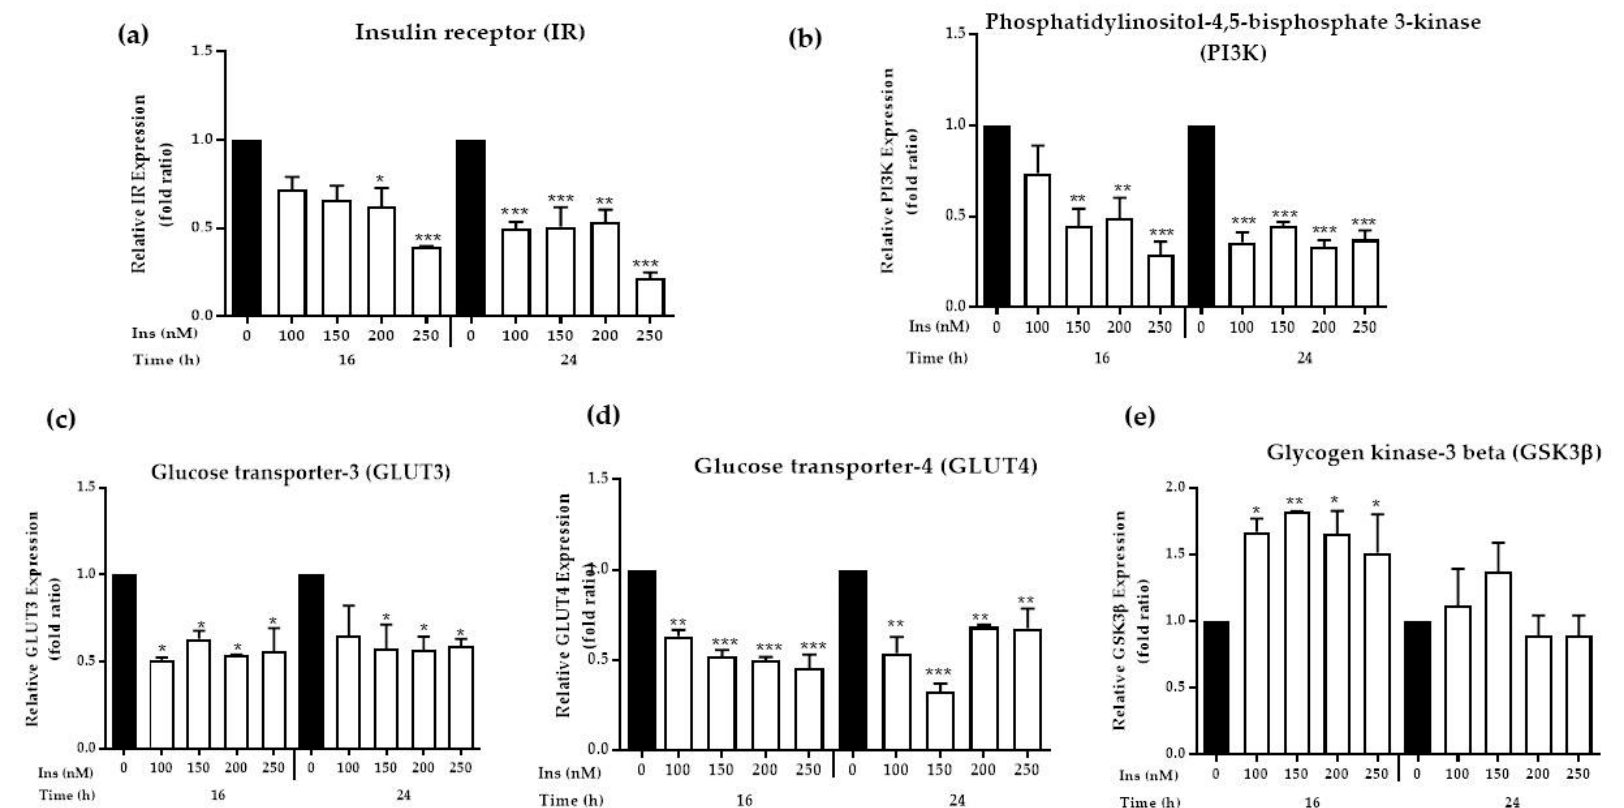
Figure 2. E ff ects of prolonged insulin induction on insulin signal transduction cascade in SK-N-SH cells line. Serum deprived cells were incubated in the absence (control) or presence of insulin for 16 and 24 h, and challenged with 100 nM insulin for 30 minutes. Total RNAs were prepared and subjected to reverse transcriptase. The resulting cDNAs were used to perform Real-time PCR as described in Section 2.5 using specific primers for ( a ) IR ; ( b ) PI3K ; ( c ) GLUT3 ; ( d ) GLUT4 and ( e ) GSK3 β . GAPDH was used to normalize the expression level. Data were expressed as mean ± SEM of three independent experiments. Significant values were expressed as * p < 0.05, ** p < 0.01 and *** p < 0.001 compared to the negative control group.